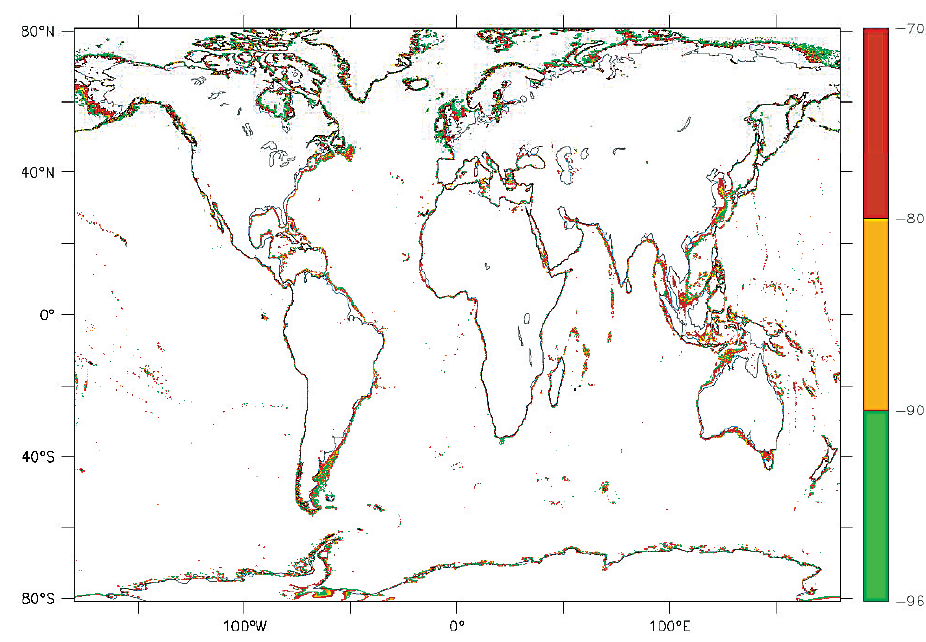
Fig. 6. Areas flooded during MWP-1A. Changes in relative sea level from − 96m to − 70m are plotted from the most recent update (version 12.1) of a global bathymetry (Smith and Sandwell, 1997) with 1 min spatial resolution ranging from 81 ◦ S to 81 ◦